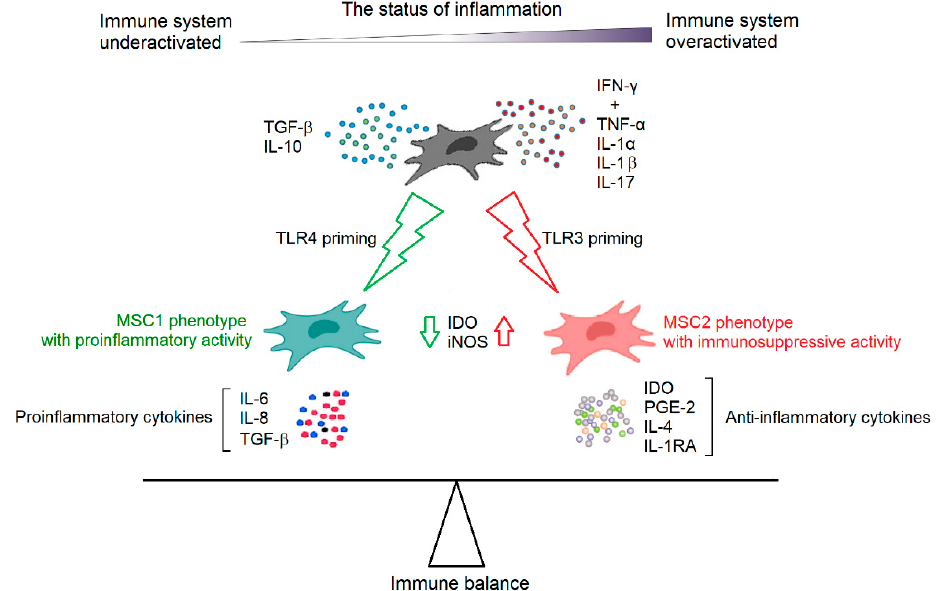
Figure 3. Plasticity of MSCs in immunomodulation. Being receptive to environmental signals, MSCs can gain immunomodulatory capacity for both promoting and inhibiting immune reactions. IDO and/or iNOS serve as an “on-off” switch that determines the outcome of immunomodulation by MSCs.